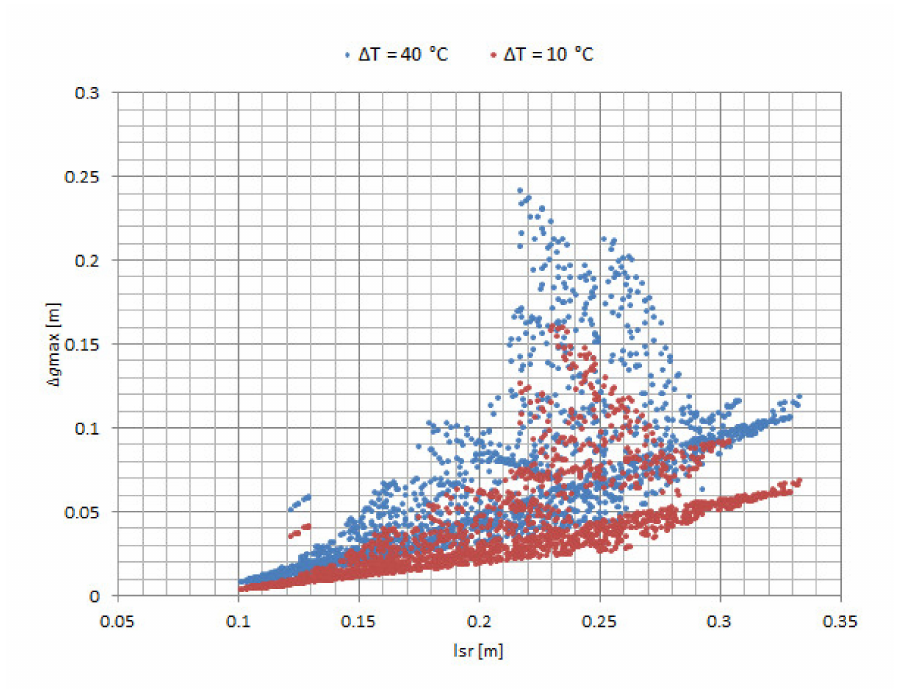
Figure 9. Maximum change in the result for detecting the location of PD ∆ g max in the second simulation depending on the mean distance between the PD and AE sensor l sr for temperature changes ( ∆ T ) of 10 ◦ C and 40 ◦